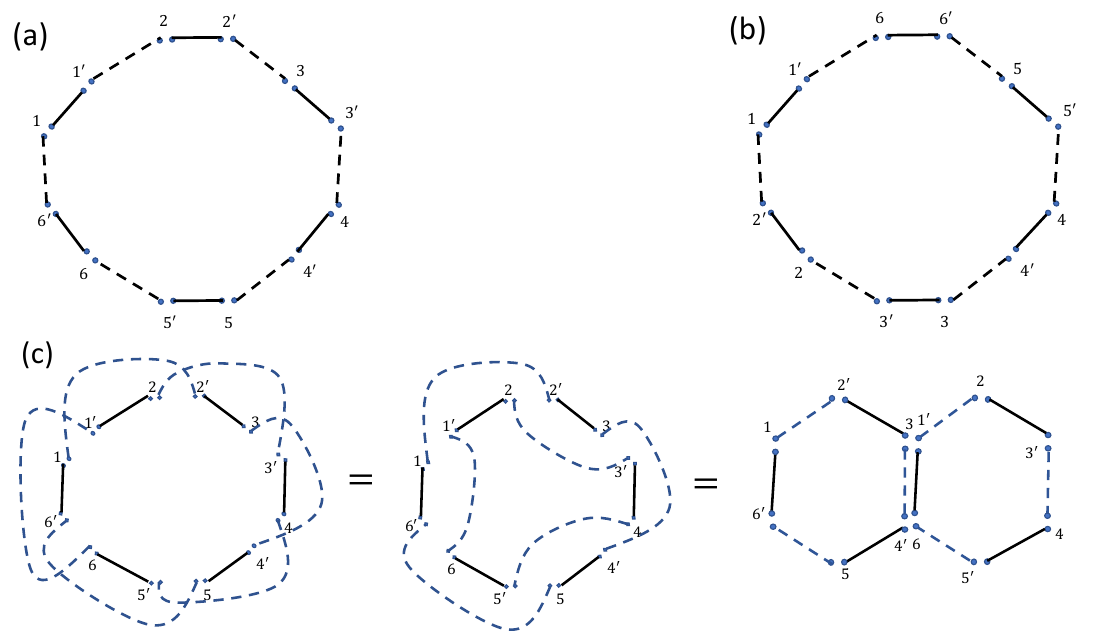
Figure 19 . Boundary conditions for the diagrams corresponding to the three terms in the second line of